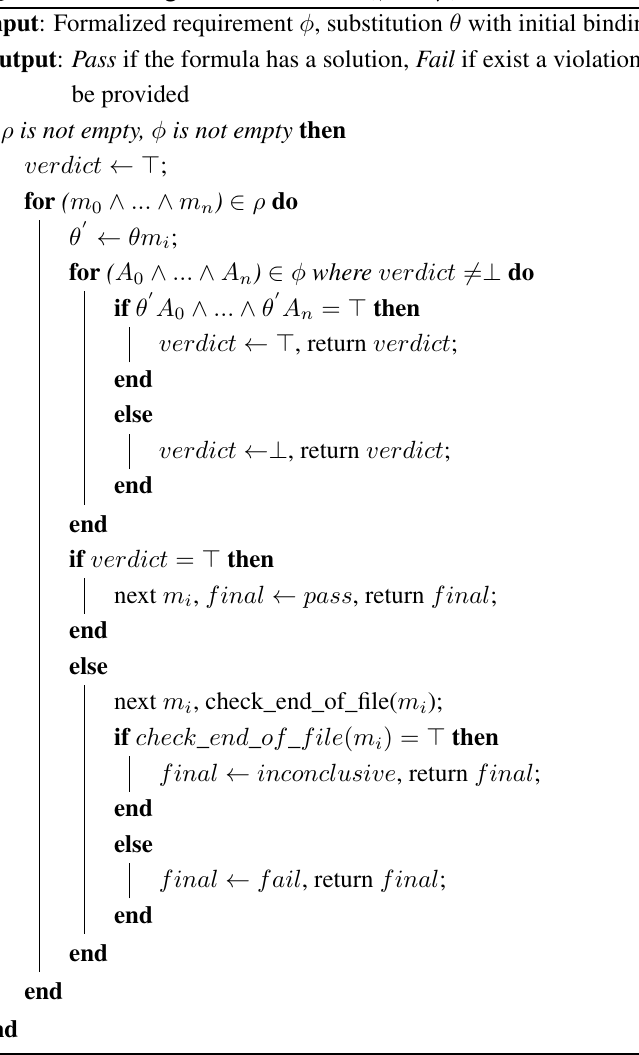
Algorithm 1: Algorithm for eval ( φ , θ , ρ